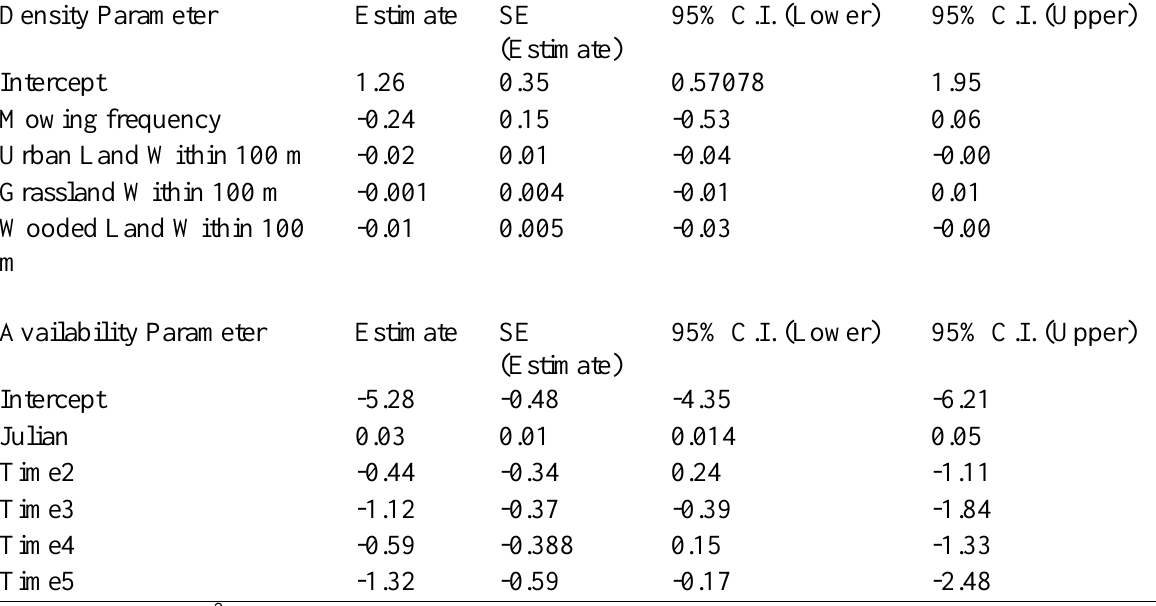
Table A2.E . Highest-ranking hierarchical distance-sampling model (AIC AIC weight=0.33) for Clay-coloured Sparrows along 44 transmission line study sites in Winnipeg, Manitoba, Canada in 2009 (n=132 surveys), assuming a uniform detection probability with increasing distance of birds from the transect line and effects of Julian date and time of morning but not observer experience on availability for